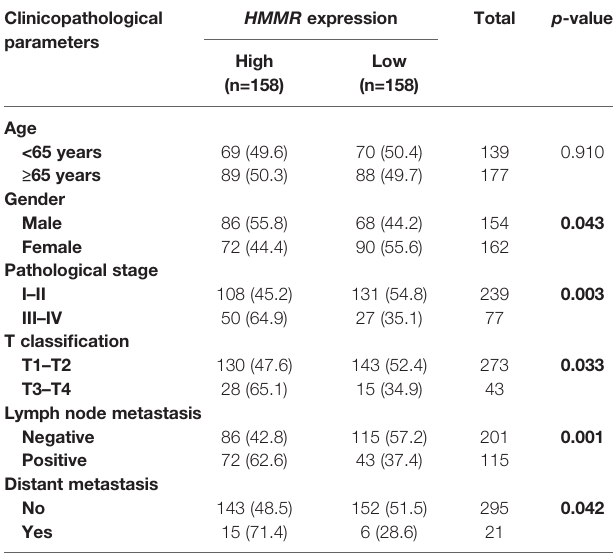
TABLE 3 | Relationships between HMMR expression and clinicopathological parameters in LUAD. Clinicopathological